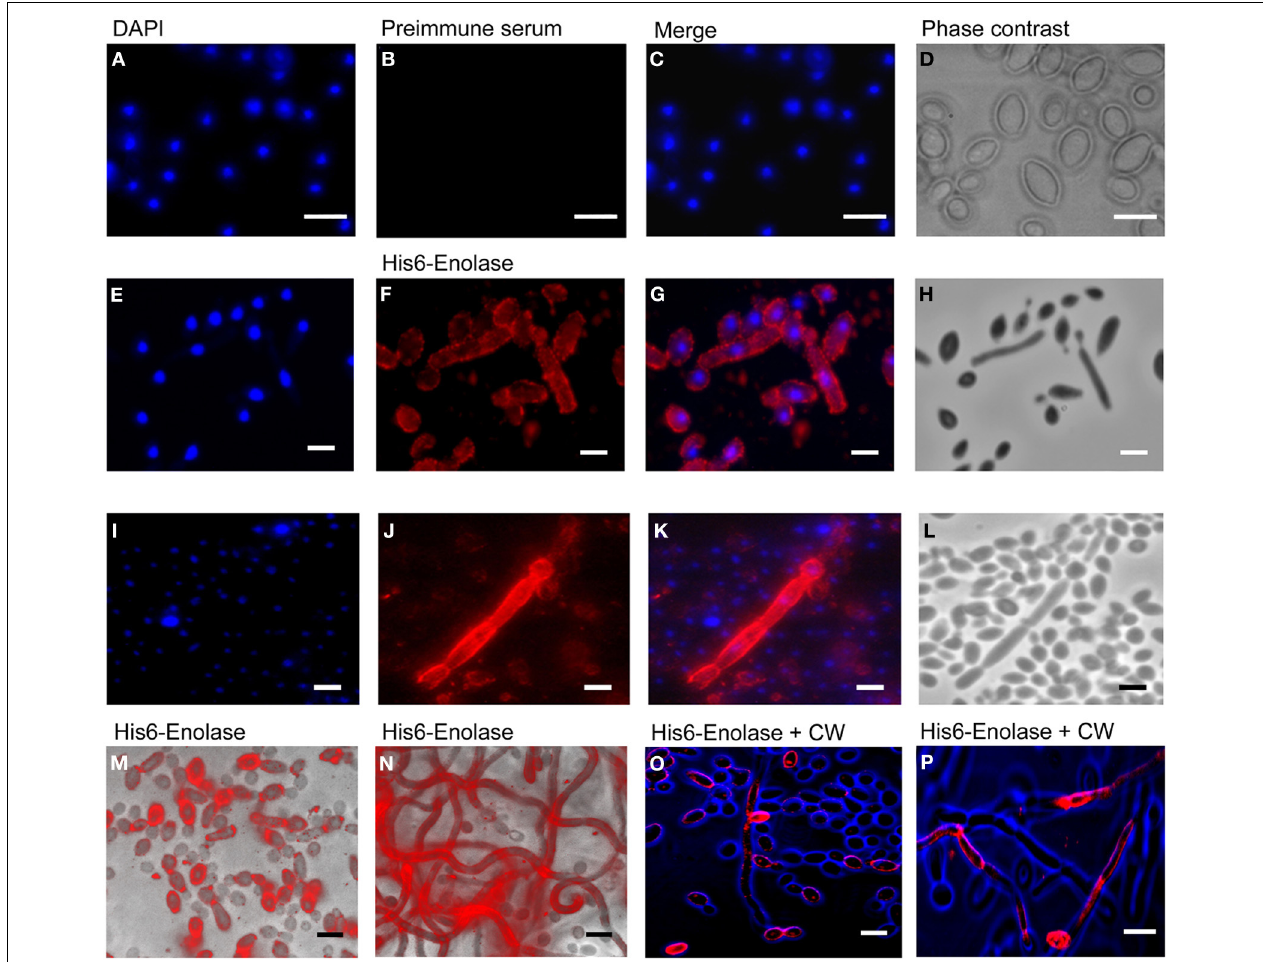
FIGURE 3 | Immunofluorescence of native enolase detected in yeasts, hyphae and biofilm-forming cells of C. albicans SC5314. Immunofluorescence of yeasts permeabilized with saponin 1%: (A) DAPI (1:2000); (B) Pre-immune serum (1:80); (C) Merged images and (D) Phase contrast image. Immunofluorescence of non-permeabilized yeast and filaments cells: (E) DAPI (1:2000); (F) anti His 6 -enolase polyclonal serum (1:80); (G) Merged images and (H) Phase contrast image. Filaments permeabilized with saponin 1%: (I) DAPI (1:2000); (J) anti His 6 -enolase polyclonal serum (1:80); (K) Merged images and (L) Phase contrast image. Presence of enolase in biofilm cells permeabilized with